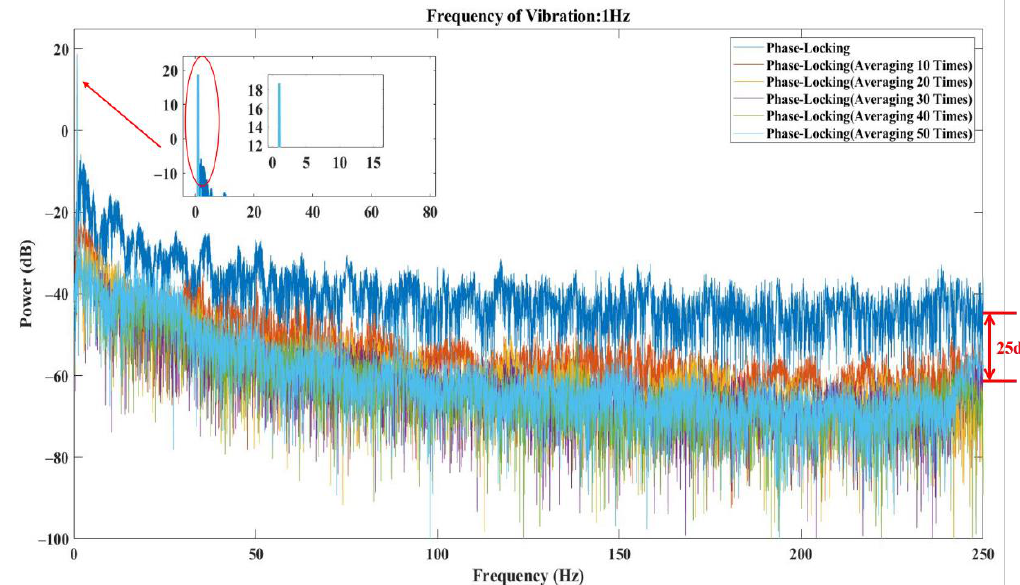
Figure 9. Spectrogram of 1 Hz vibration events applied on PZT with different averaging windows (spectrum range: 0~250 Hz).